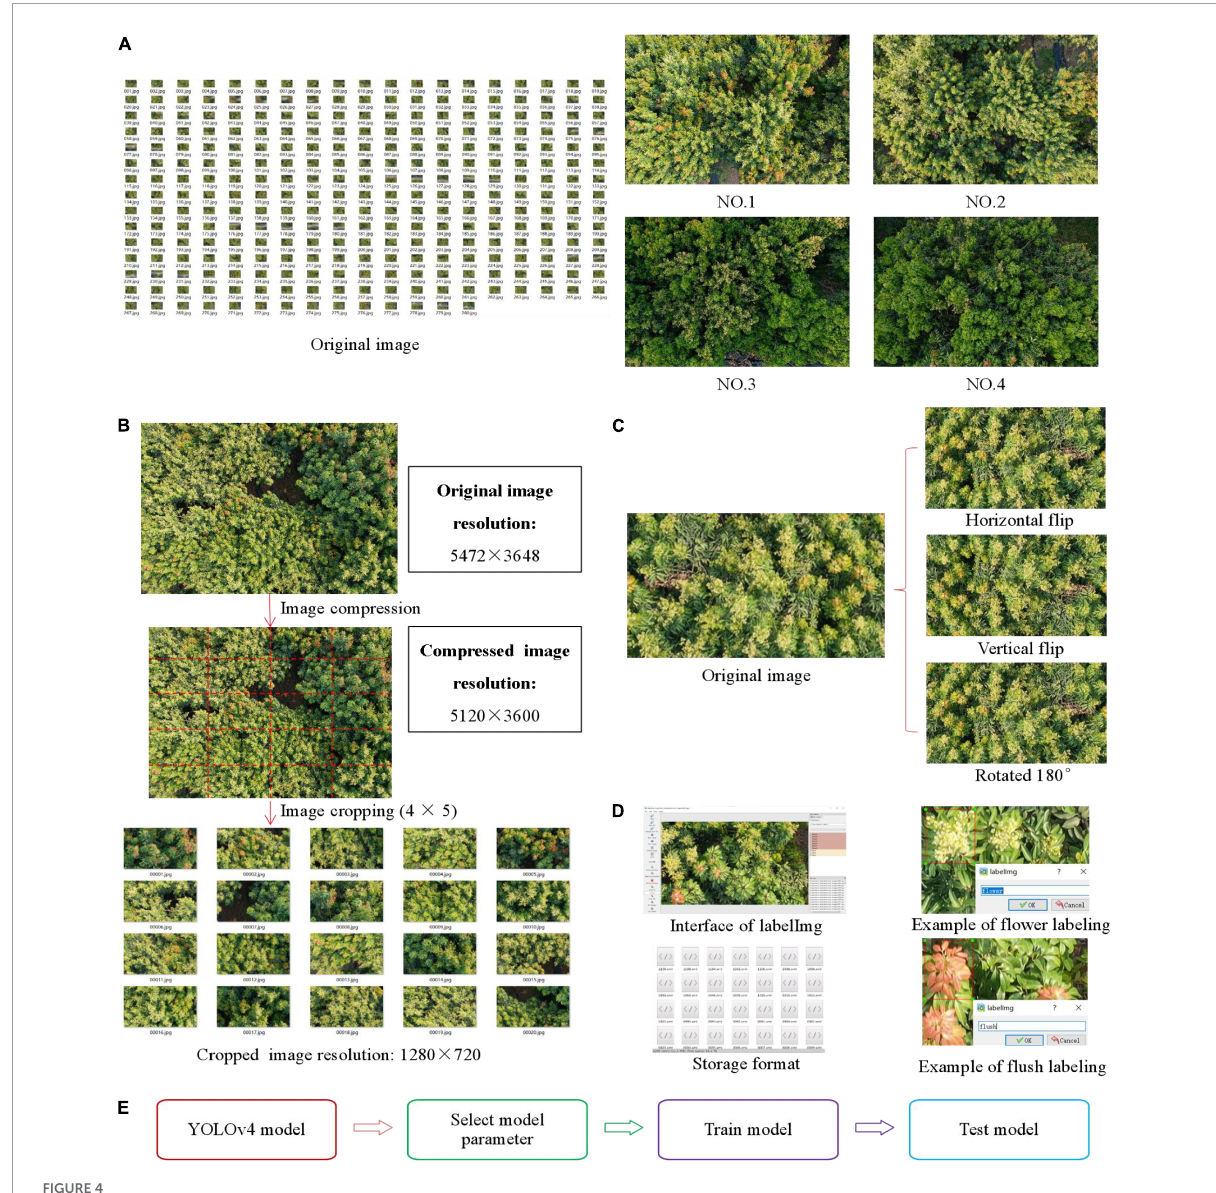
FIGURE4 Materials, image acquisition, image preprocessing, image annotation, and model training. (A) Image data collected by UAV. (B) Image cropping process. (C) Data enhancement process. (D) Data annotation process. (E) Whole training process.